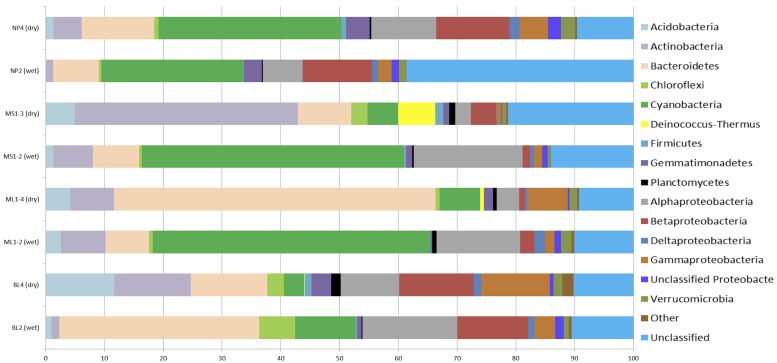
Percentage composition of bacterial communities as based 16S rRNA-based amplicon pyrosequencing. The category ‘Other’ includes the phyla: BRC1, OD1, TM7, OP10, Nitrospira, SR1, and WS3. The total number of sequences for each sample: NP4, 7236; NP2, 24000; MS1-3, 5142; MS1-2, 10366; ML1-4, 7163; ML1-2, 7640; BL4, 9957; BL2, 7033.